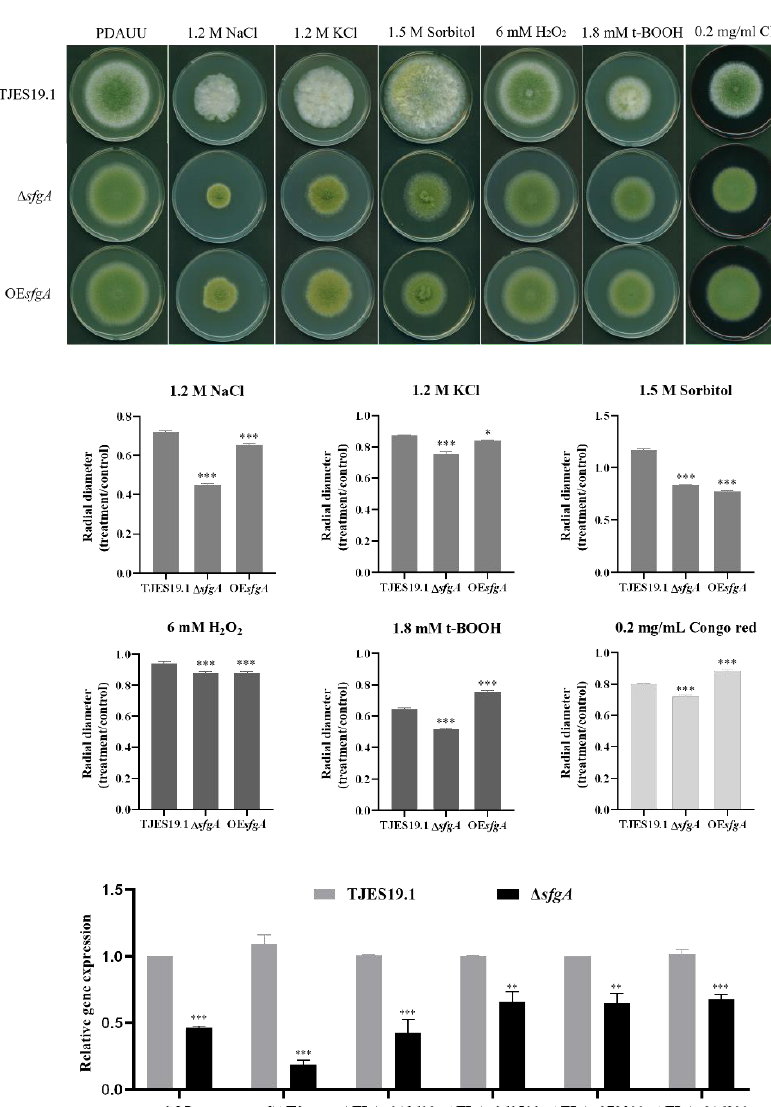
Figure 6. Phenotypes of the ∆ sfgA mutant in various stress conditions. ( A ) TJES19.1, ∆ sfgA , and OE sfgA strains were point-inoculated on solid PDAUU media containing various compounds including NaCl, KCl, sorbitol, H 2 O 2 , t-BOOH, and CR at 30 ◦ C for 5 days. ( B ) Quantitative analysis of colony diameter shown in ( A ). ( C ) qPCR analysis of transcriptional levels of oxidative and cell-wall-related genes of mycelia cultured on PDAUU at 30 ◦ C for 24 h. Gene expression levels at each time point were normalized to β -actin by 2 −ΔΔ CT analysis. * p ≤ 0.05; ** p ≤ 0.01; *** p ≤ 0.001.